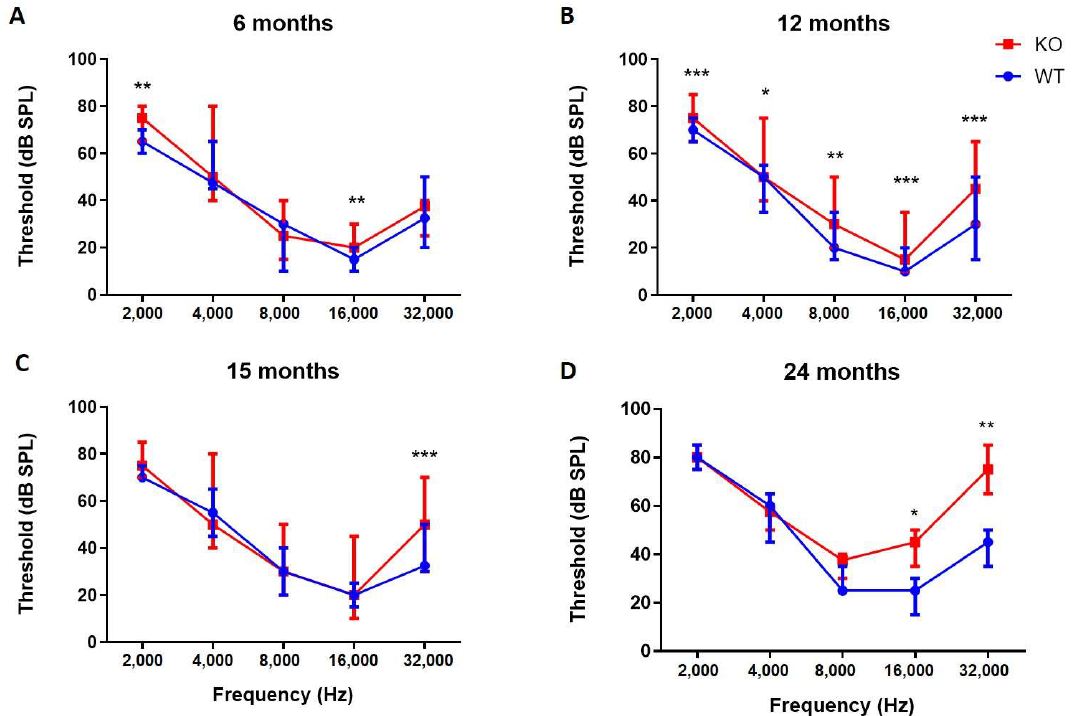
Figure 2. Auditory Brainstem Responses (ABR) thresholds between Coch +/+ ( n = 12 ) and Coch −/− mice ( n = 8 ) at 6 months ( A ), ABR thresholds between Coch +/+ ( n = 22 ) and Coch −/− mice ( n = 30 ) at 12 months ( B ), ABR thresholds between Coch +/+ ( n = 10 ) and Coch −/− mice ( n = 23 ) at 15 months ( C ) and ABR thresholds between Coch +/+ ( n = 5 ) and Coch −/− mice ( n = 5 ) at 24 months ( D ). Data is represented as median with interquartile range. * indicates p < 0.05, ** indicates p < 0.01, *** indicates p < 0.001.